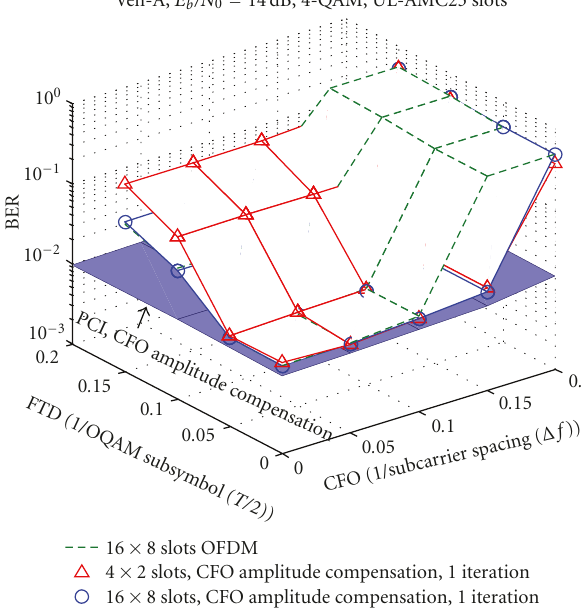
Figure 9: BER performance versus CFO and FTD for uplink transmission of 16 × 8 and 4 × 2 AMC23 slots in Vehicular-A channel at E b /N 0 = 14dB using 4-QAM. OFDM- and FBMC-based WiMAX. FBMC Synchronization performed with CFO amplitude compensation in the 3-tap equalizer and one synchronization iteration.